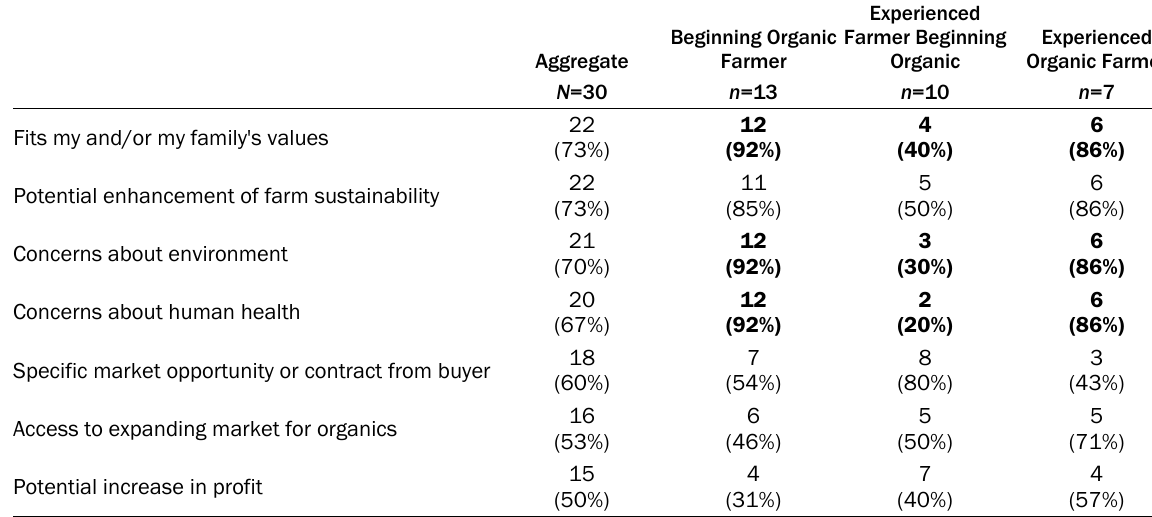
Table 5. Number and Percentage of Farmers Indicating a Factor was a Motivation to Pursue Organic